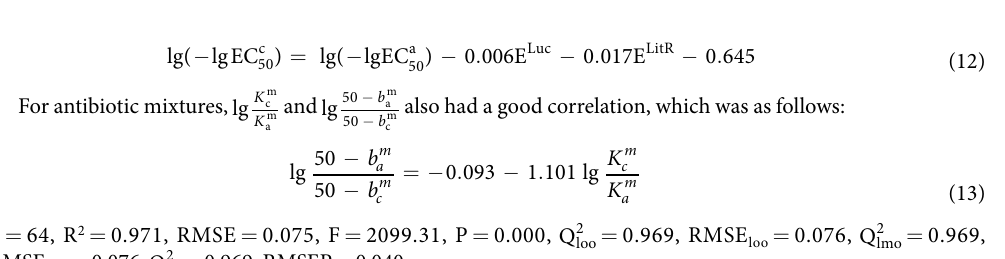
Figure 6. ( A ) Plots of experimental versus predicted − sets with a warning leverage h * =